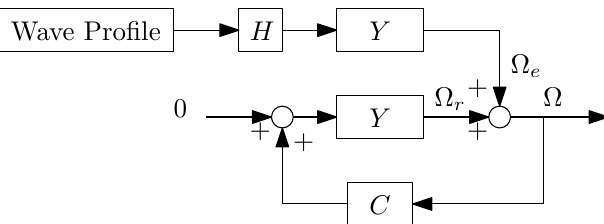
Fig. 4: Modified block diagram of the linear